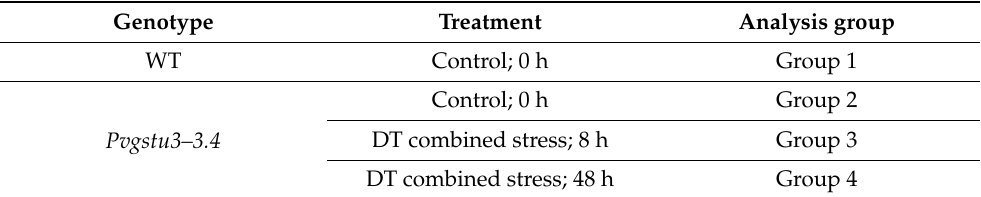
Table 6. Plant material used for RNA extraction and transcriptomics analysis with of the WT and Pvgstu3–3.4 transgenic line with 2 and 6 biological replicates, respectively, under stress-free and DT combined stress conditions at different time